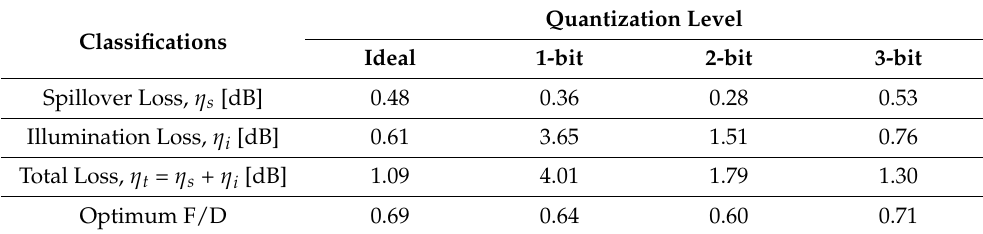
Table 1. Total efficiency of transmitarray in variation of quantization level.